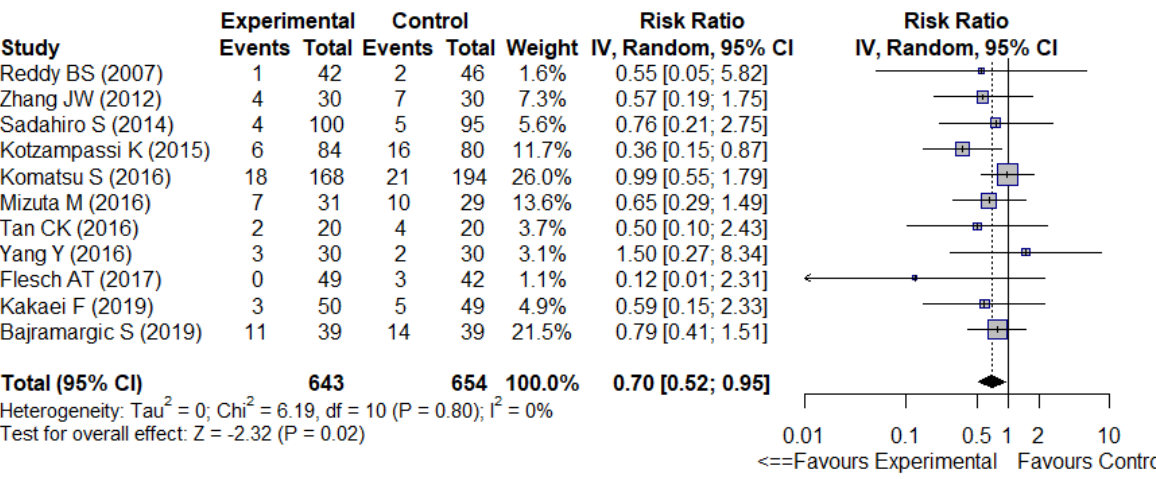
Figure 3. Forest plot of surgical site infections [24,28,31,32,34 – 36,38,39,41].